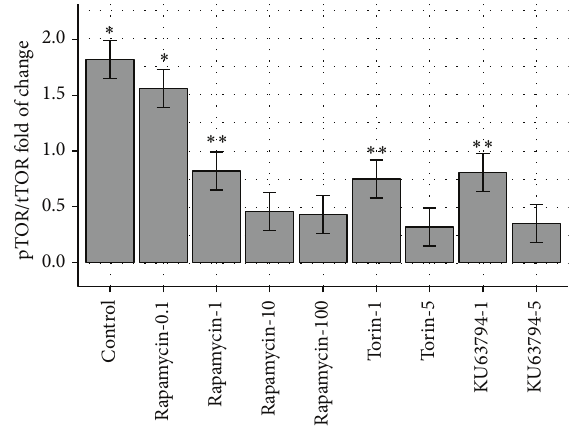
Figure 4: A graphic representation of activated mTOR expressed as phosphor/total mTOR. It indicates the activated fraction at the control (without inhibitor) with Rapamycin at doses 0.1, 10, and 100ng/mL, Torin at doses 1 and 5 ng/mL, and KU63794 at doses 1 and 5 ng/mL. Rap-0.1: Rapamycin 0.1 ng/mL,